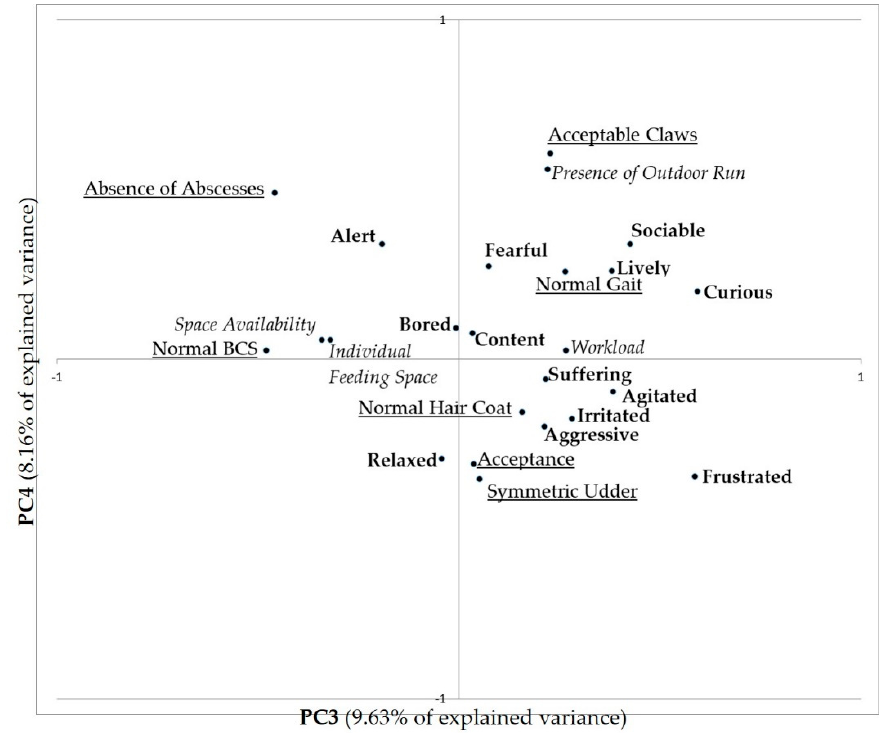
Figure 2. Loadings of QBA descriptors (in bold), other quantitative animal-based measures (underlined), and resource-based measures (in italics) along the third and fourth PCs for the 60 farms.